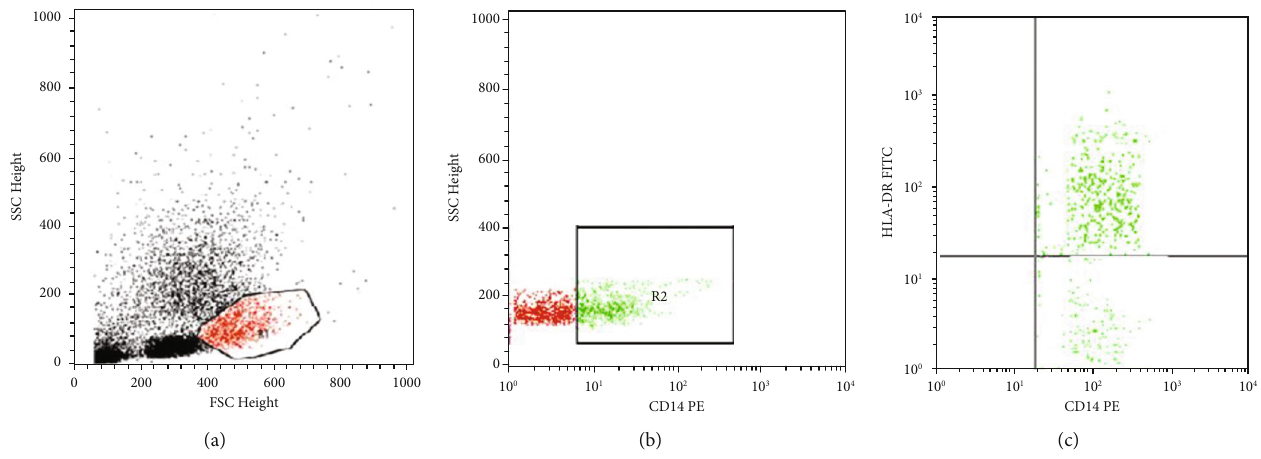
Figure 1: Flow cytometric detection of Mo-myeloid derived suppressor cells (Mo-MDSCs). (a) Forward and side scatter histogram was used to de fi ne the monocyte population (R1). (b) The expression of CD14 was assessed in monocytes population (R1) and CD14+ cells were then gated. (c) Then, the expression of HLA-DR on CD14+ cells (R2) was detected, to de fi ne CD14+HLA-DR- cells (Mo-MDSCs). Mo-MDSCs were expressed as a percentage of CD14+ cells. Table 1: Di ff erential accumulation of Mo-MDSCs between NSCLC patients and healthy